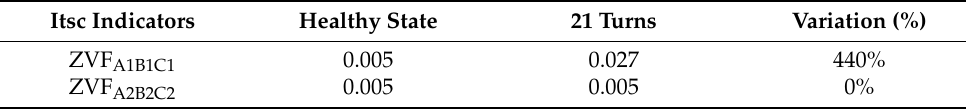
Table 2. ZVF values for two three-phase systems with 21 shorted